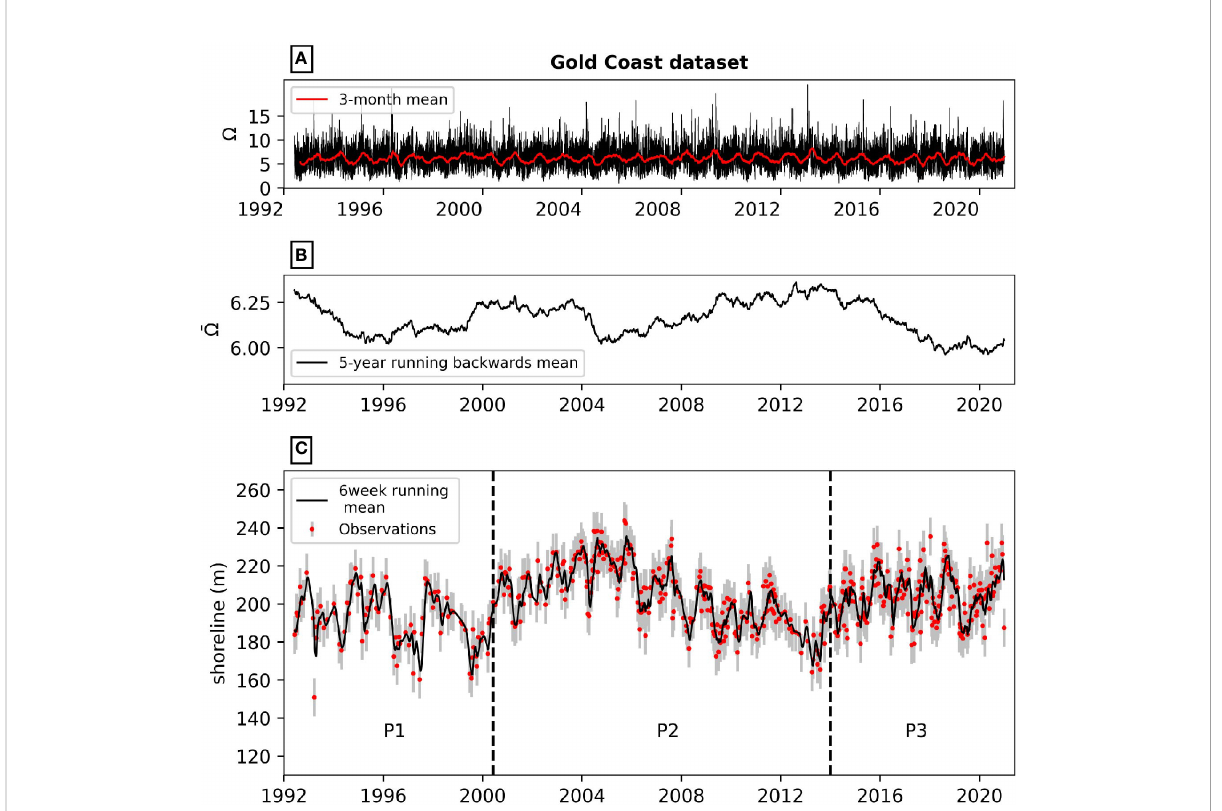
FIGURE 2 Wave and shoreline datasets. (A) Time series of dimensionless fall velocity spanning the 1992-2020 period (black line). The red line is the 3- month running mean. (B) Interannual variability of the dimensionless fall velocity, here represented by a 5-year running backwards mean. (C) Time series of shoreline evolution at the Gold Coast relative to a local datum. This data was obtained from satellite-derived shorelines (red dots with grey error bars representing the accuracy of the satellite-derived shorelines, here given by R =10 m). The black line is the 6-week centered running mean used to facilitate visualization of the seasonal to interannual variability at this study site. The dataset is split into 3 different time periods (P1, P2, P3). P2 is used for training and all three are used for testing